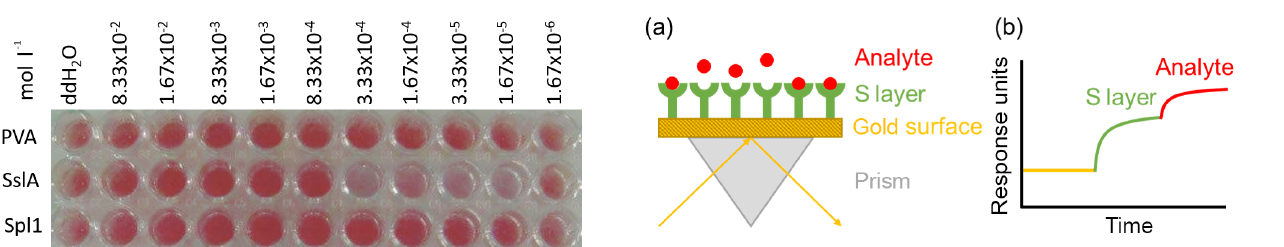
Figure 6. Colorimetric assay of PVA, SslA ( S. ureae ATCC 13881) and Slp1 ( L. sphaericus JG-B53)-functionalized AuNPs upon addi- tion of different concentrations of YCl 3 .